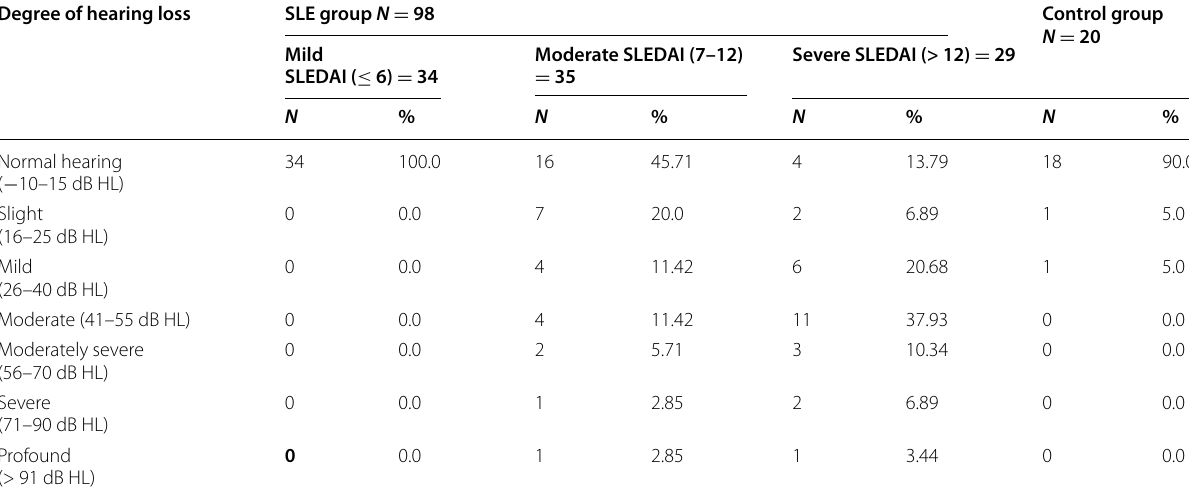
SLE systemic lupus erythematosus . dBHL decibels hearing level. SLEDAI systemic lupus erythematosus disease activity index